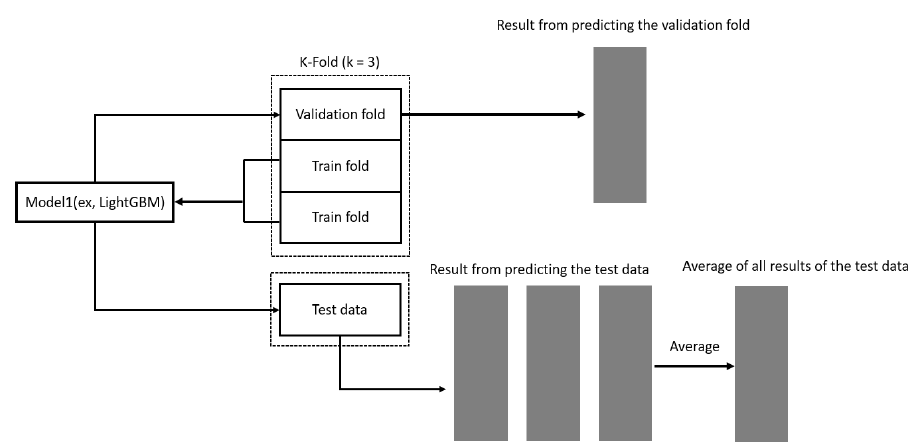
Figure 7. Summary graph of the process of CV stacking in each model.